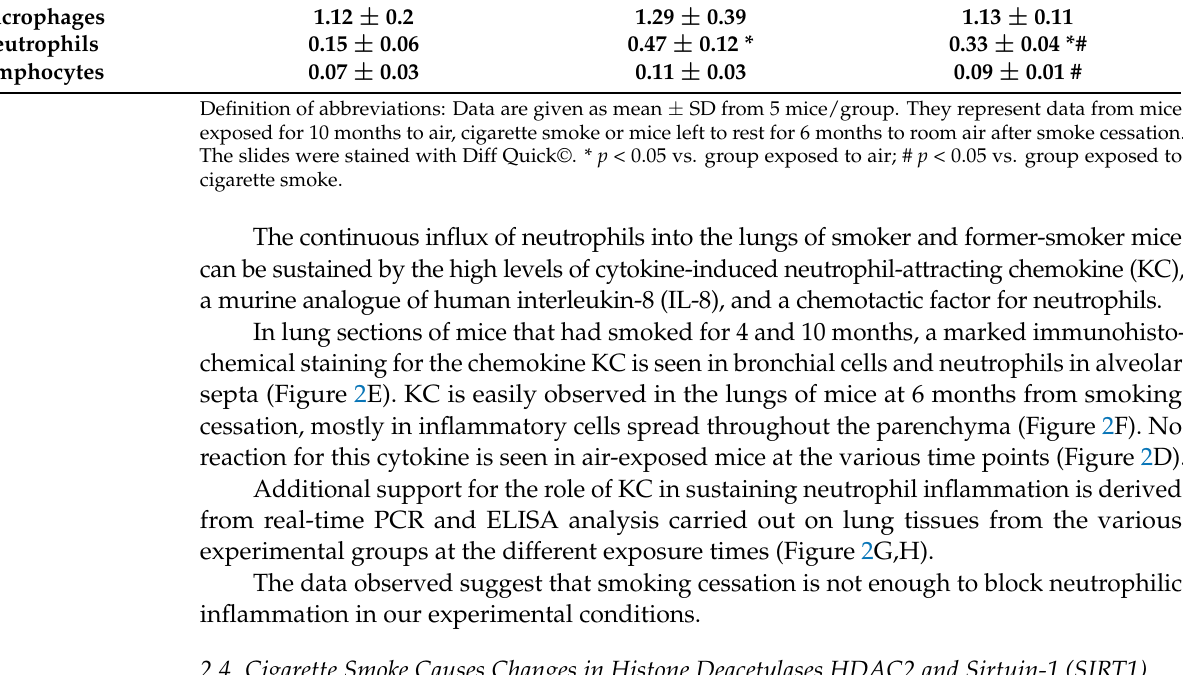
Table 2. Total and Differential Cell Count in BALFs after 10 Months from the Start of the Study. Air-Exposed Smoke-Exposed Smoke